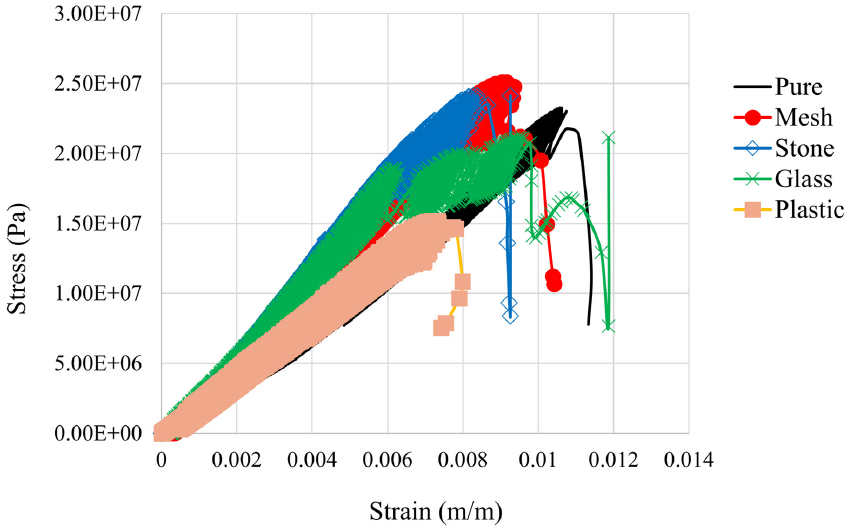
Figure 3. Stress–strain curves for five different reinforcement types.